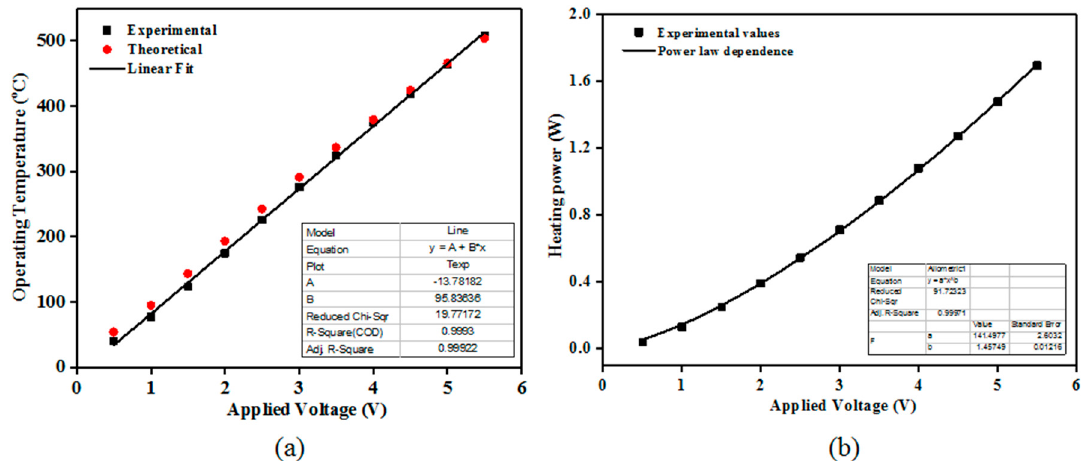
Figure 4. Calibration curves of the operating temperature ( a ) and heating power ( b ) with respect to the applied voltage (experimental and theoretical) for the TiO 2 coated gas sensor substrates. The emissivity ( ε ) was set to: 0.76 whereas the theoretical dependence was calculated based on the Pt temperature coefficient ( α ): 3.92 × 10 − 3 /°C.